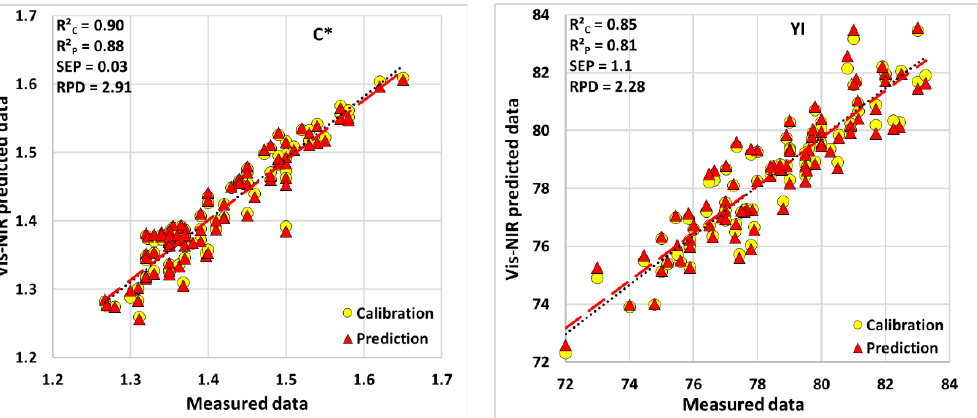
Figure 4. Illustrates the accuracy of calibration and prediction models of C * and YI color attributes of watermelon samples.